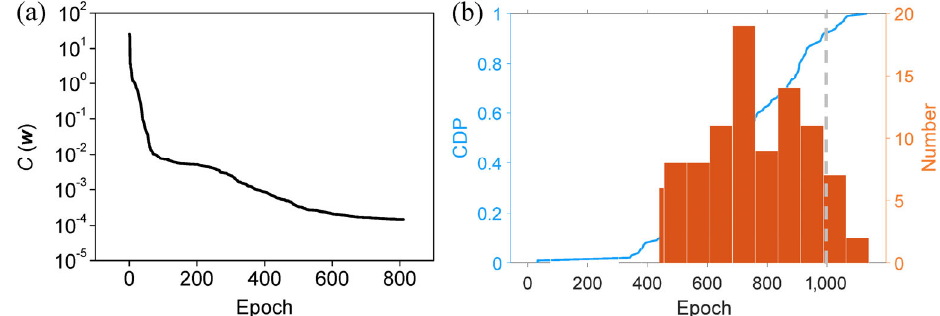
Fig. 5 Training performance. (a) Loss variation during a typical training. (b) Epoch distribution and the epoch’s cumulative distribution probability